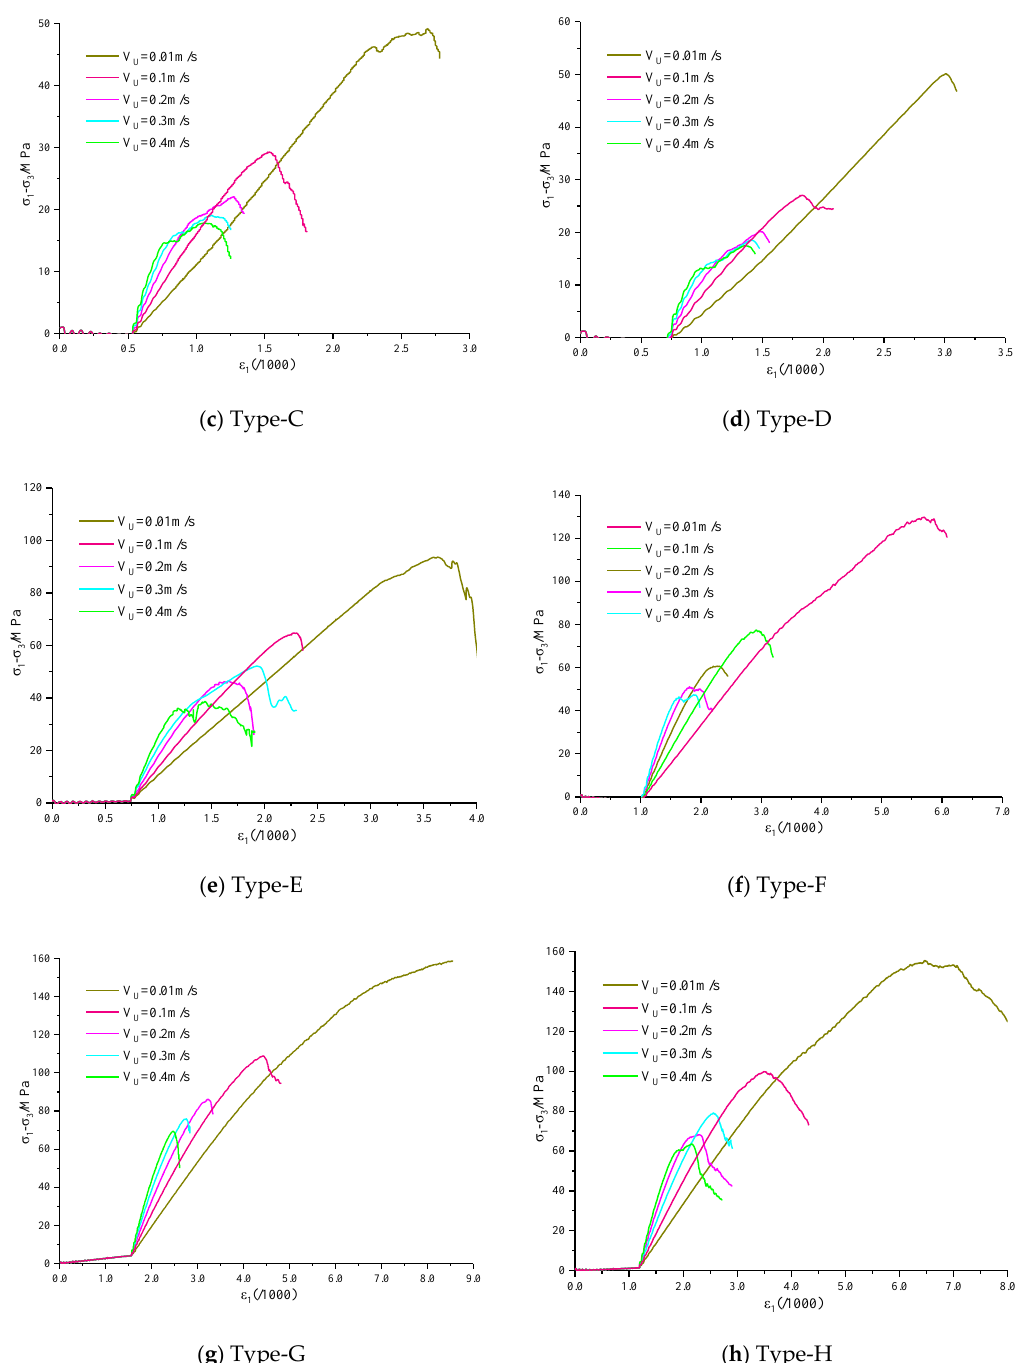
Figure 20. The numerically-predicted axial deviatoric stress–axial strain curves of pre-fissured marble specimens under unloading conditions with different rates.